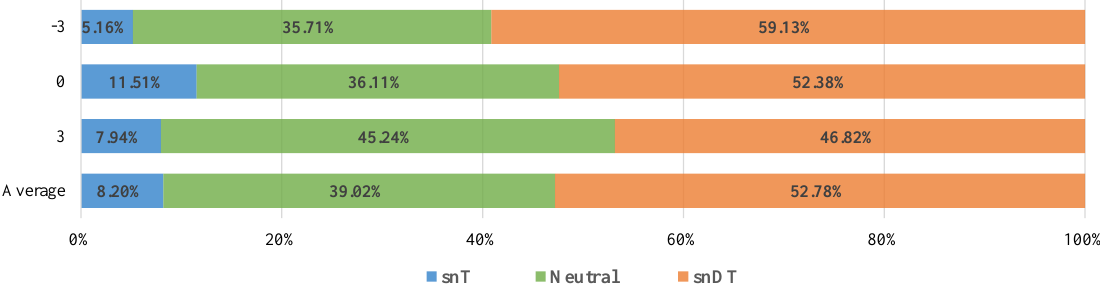
Figure 5. Results of subjective preference test ( % ) comparing the speech quality for the snT and snDT models with various SNR